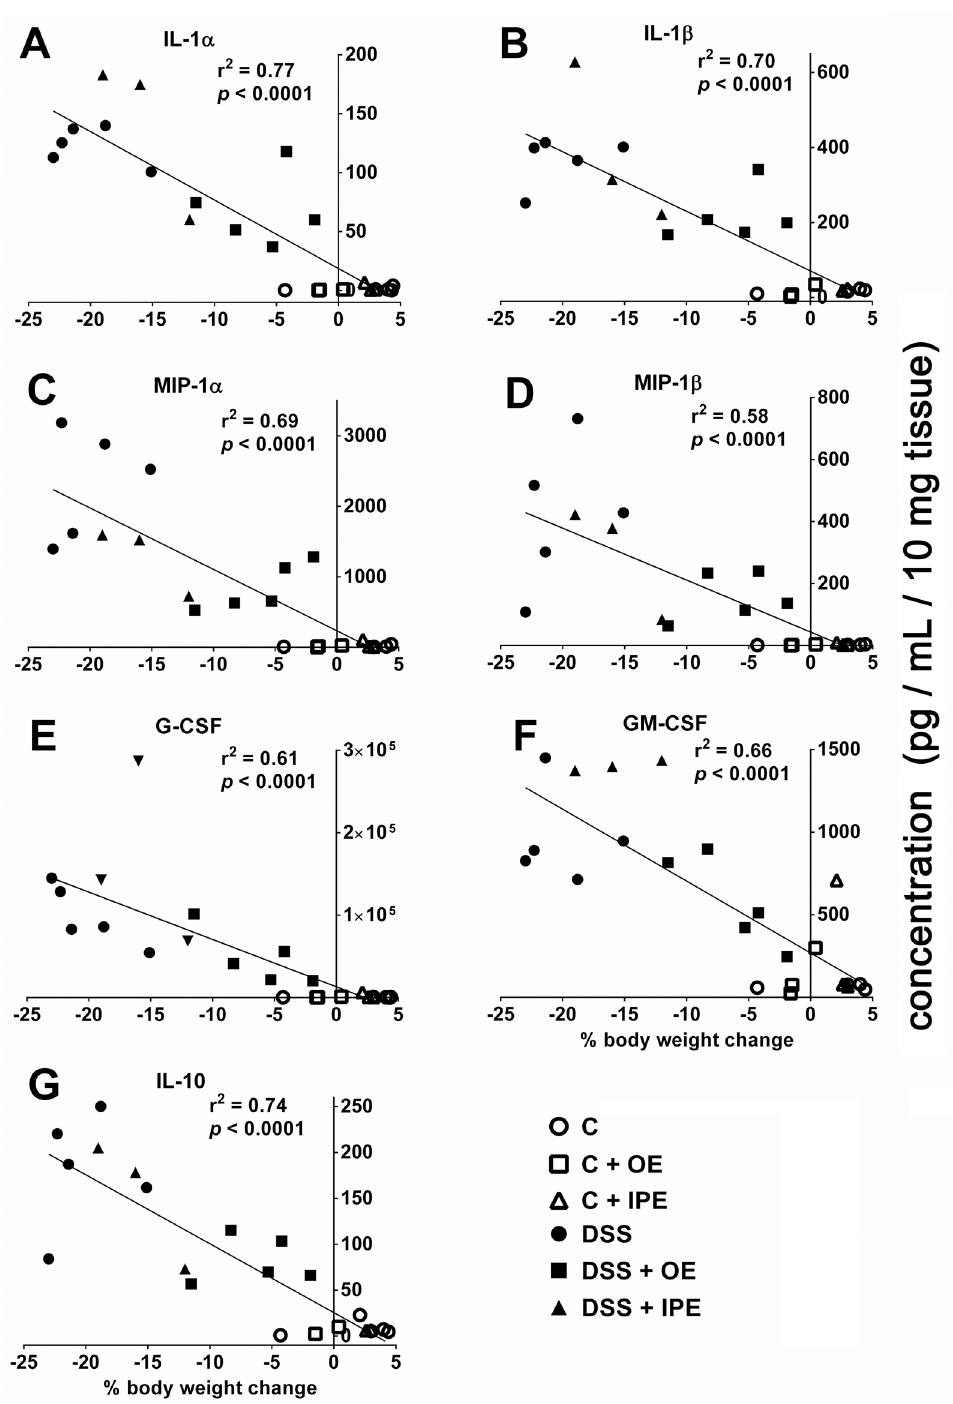
Fig 6. Correlation between colonic cytokine levels and body weight changes during acute colitis. Changes in cytokine levels were correlated with the changes of body weight of individual mice. The value of the Pearson correlation coefficient (r 2 ) is reported and significance is indicated by p value. Interleukin, IL; macrophage inflammatory protein, MIP; granulocyte colony-stimulating factor, G-CSF; granulocyte – macrophage colony-stimulating factor, GM-CSF; Control, C; control with oral enoxaparin, C+OE; control with intraperitoneal injection of enoxaparin, C+IPE; untreated colitis, DSS; colitis with oral enoxaparin, DSS+OE; colitis with intraperitoneal injection of enoxaparin, DSS+IPE.